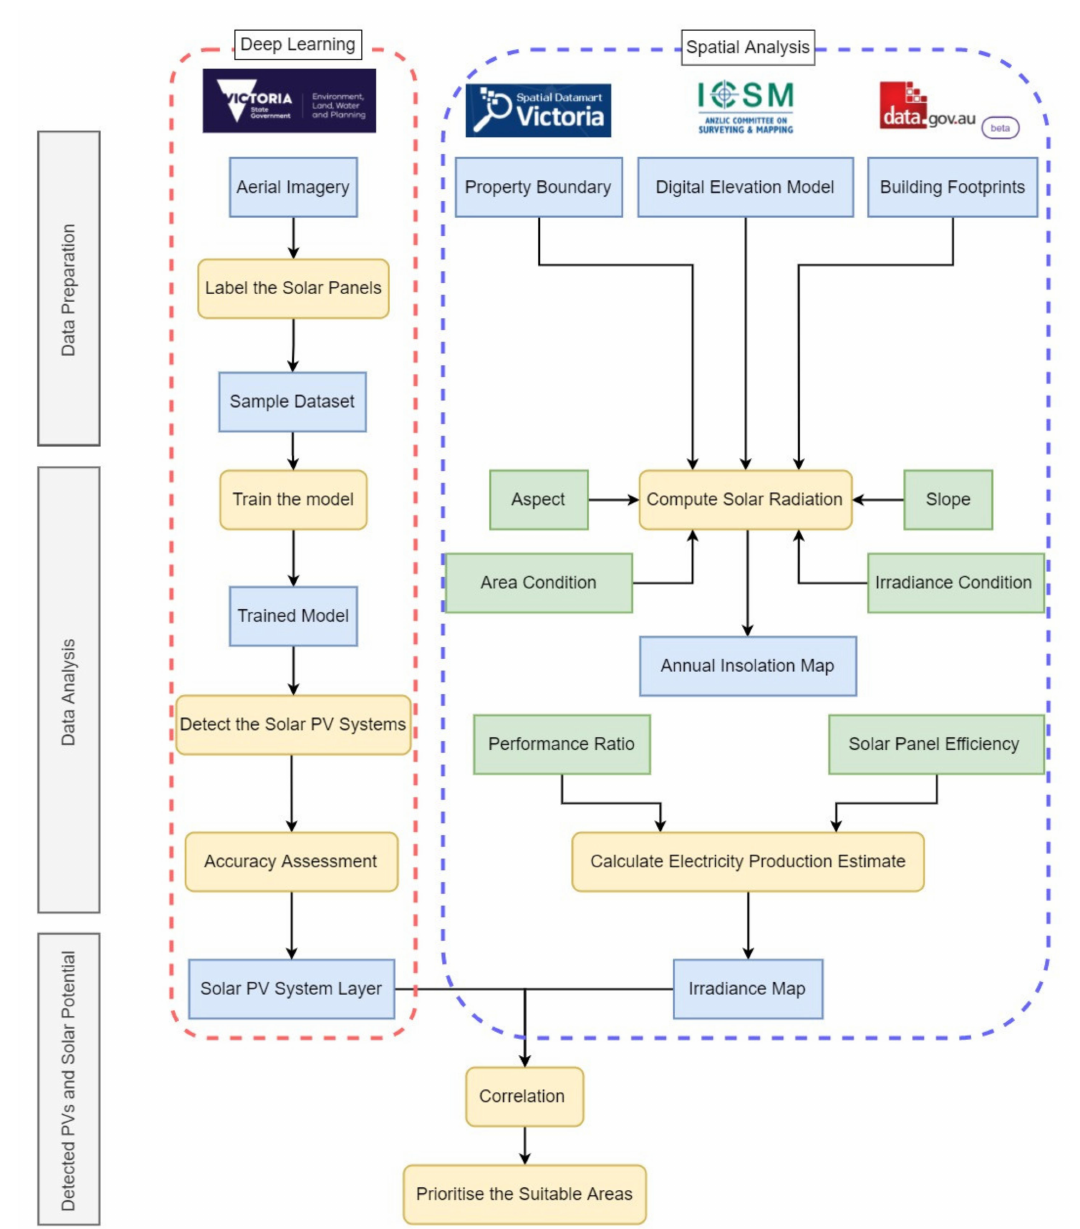
Figure 3. Research methodological